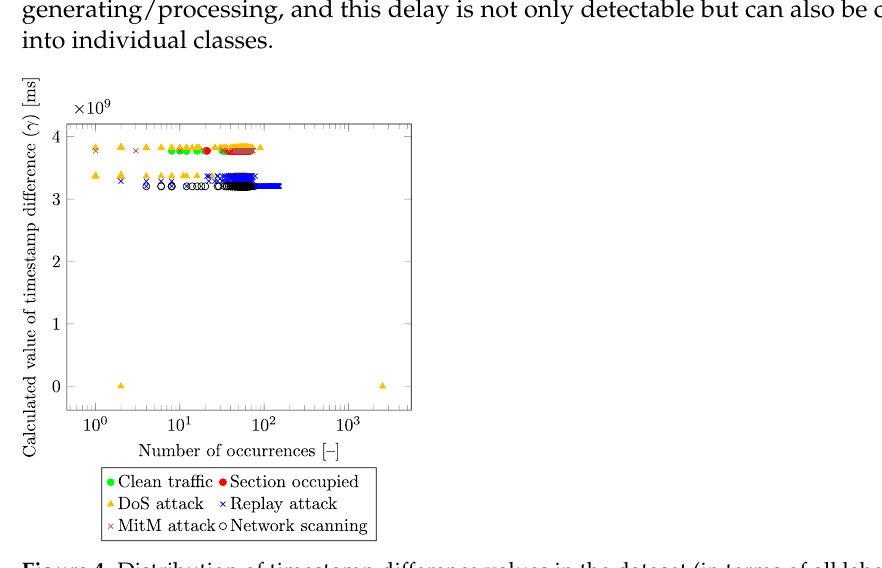
Figure 4. Distribution of timestamp difference values in the dataset (in terms of all labels).